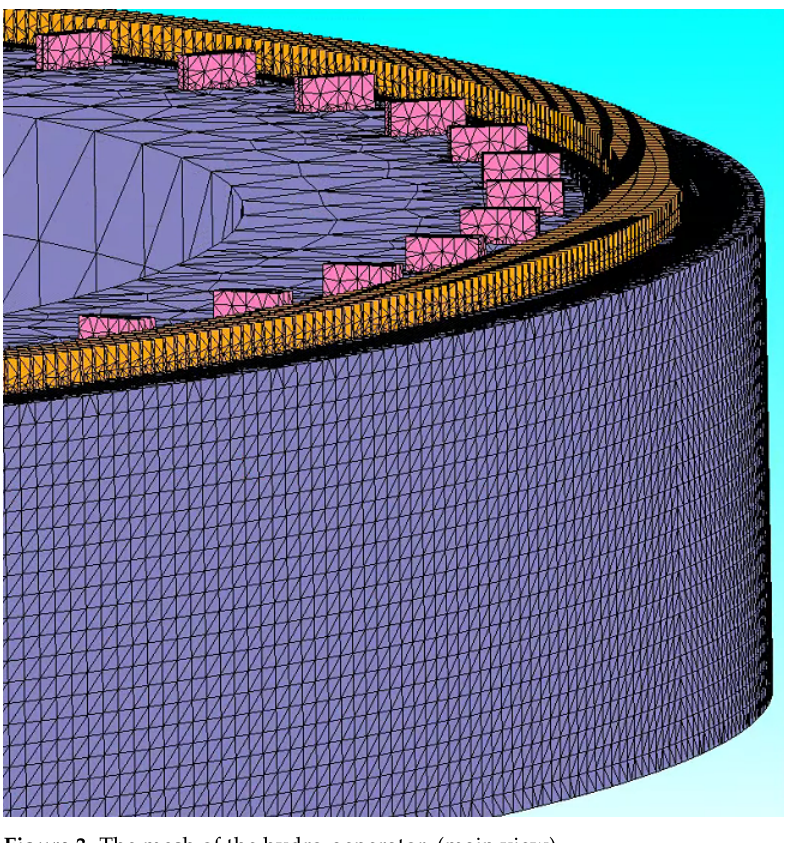
Figure 3. The mesh of the hydro-generator. (main view).